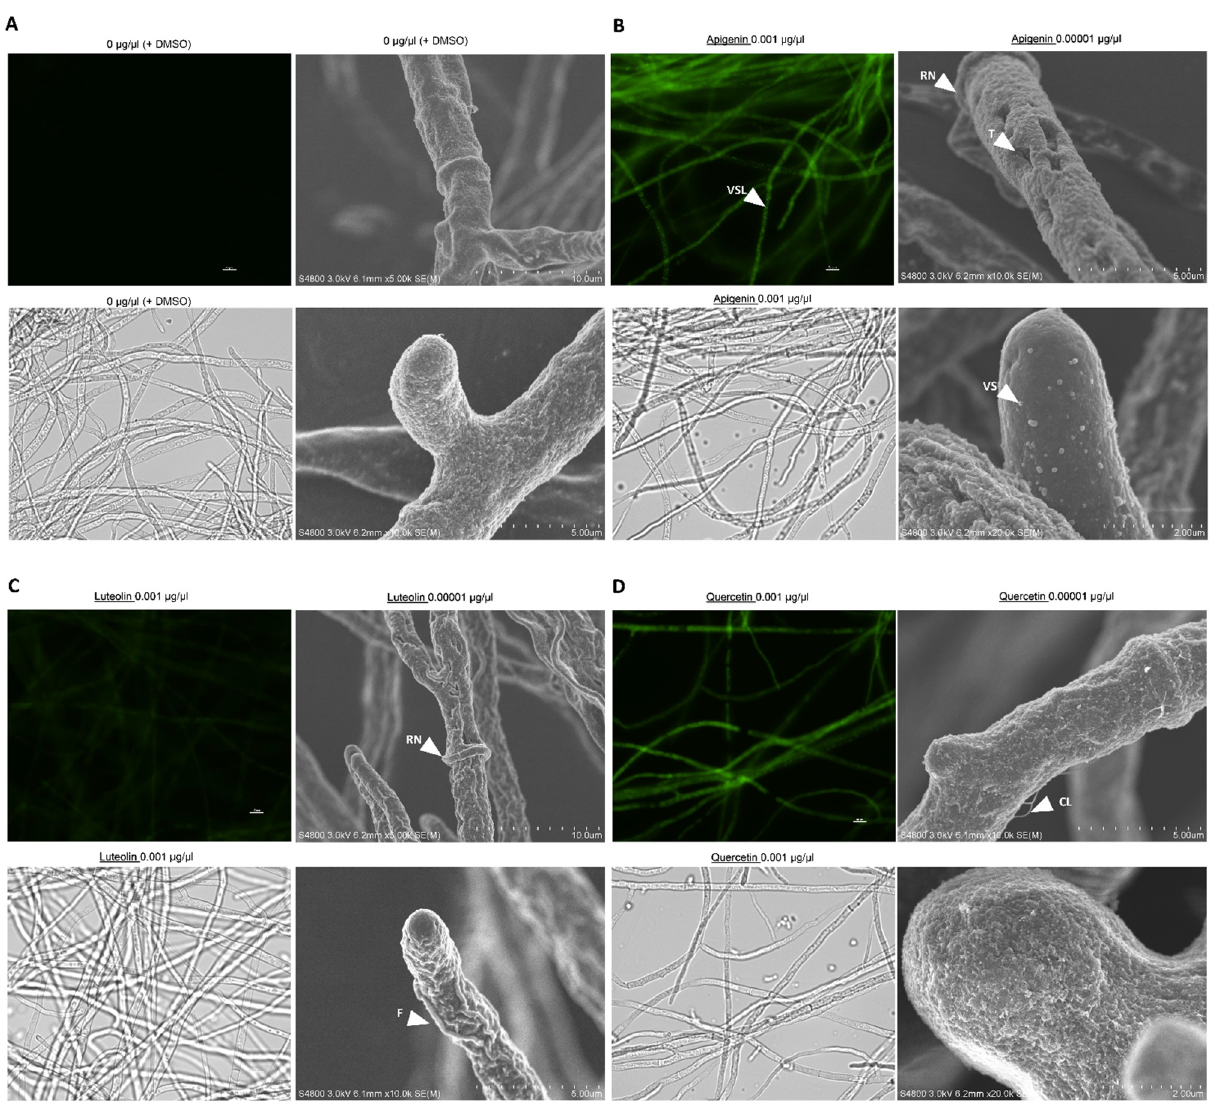
Figure 3. Flavonoids accumulate in spherical structures inside mycelia and disrupt physical prop- erties of the cell wall. DPBA assay (visualized with fluorescence), light microscopy, and SEM of AF3357 strain exposed to flavonoids. ( A ) Control (0 µ g/ µ L with 1% DMSO); ( B ) 0.001 and 0.00001 µ g/ µ L apigenin; ( C ) 0.001 and 0.00001 µ g/ µ L luteolin; and ( D ) 0.001 and 0.00001 µ g/ µ L quercetin. White bars and ticks represent scale of the microscope image. In the figures, indicate RN: ring-like structure, VS: vesicle structure, VSL: vesicle-like structure, F: fold, CL: cloud-like peels, and T: tear-like structure.